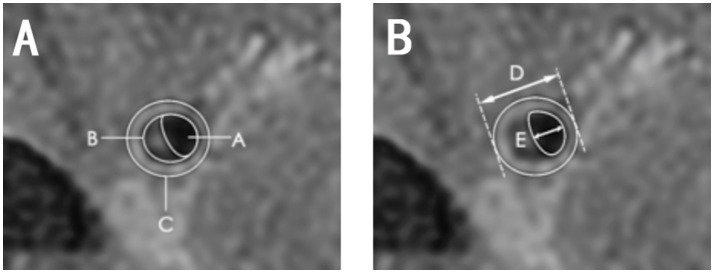
Diagram of quantitative measurements on HRMRI T2WI. (A) Area A, lumen area; area B, plaque area; area C, vessel area; C-A, wall area; (B) length D, vessel diameter; length E, lumen diameter, D-E, wall thickness.